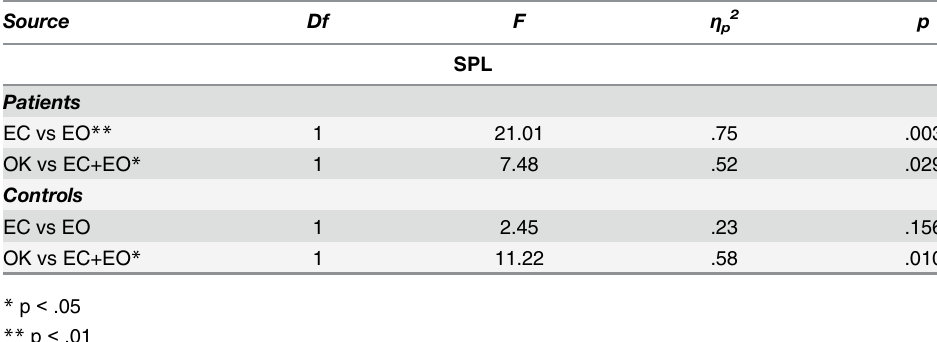
Table 2. Difference contrasts for the interaction between group and measurement type separated for each group for